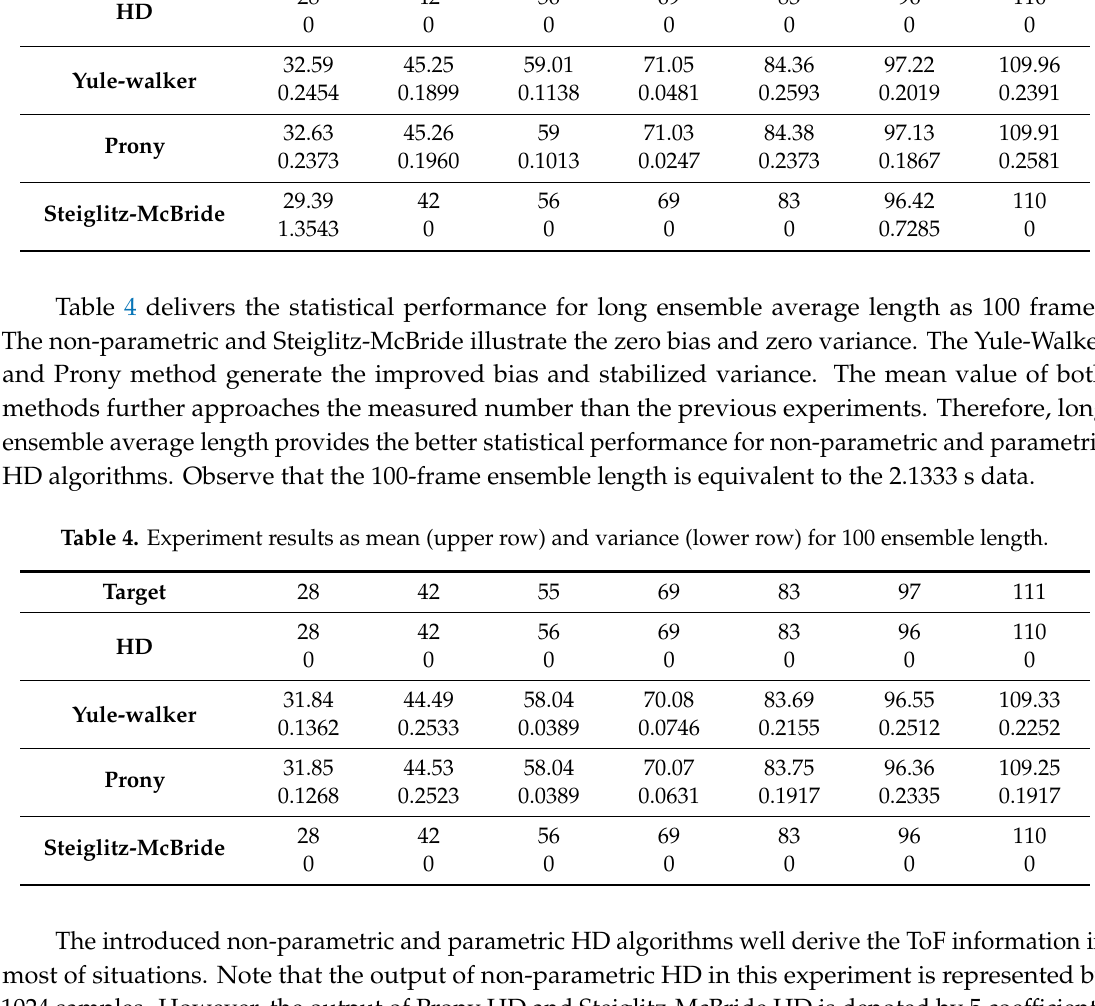
Table 3. Experiment results as mean (upper row) and variance (lower row) for 50 ensemble length.